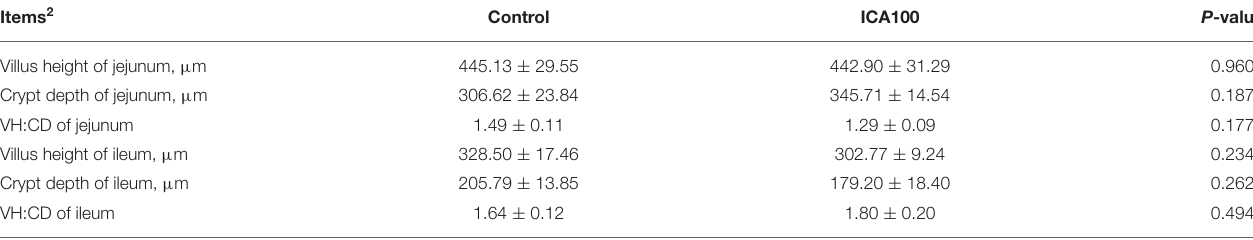
TABLE 3 | Effects of dietary ICA supplementation on the intestinal morphology of weaned piglets 1 .